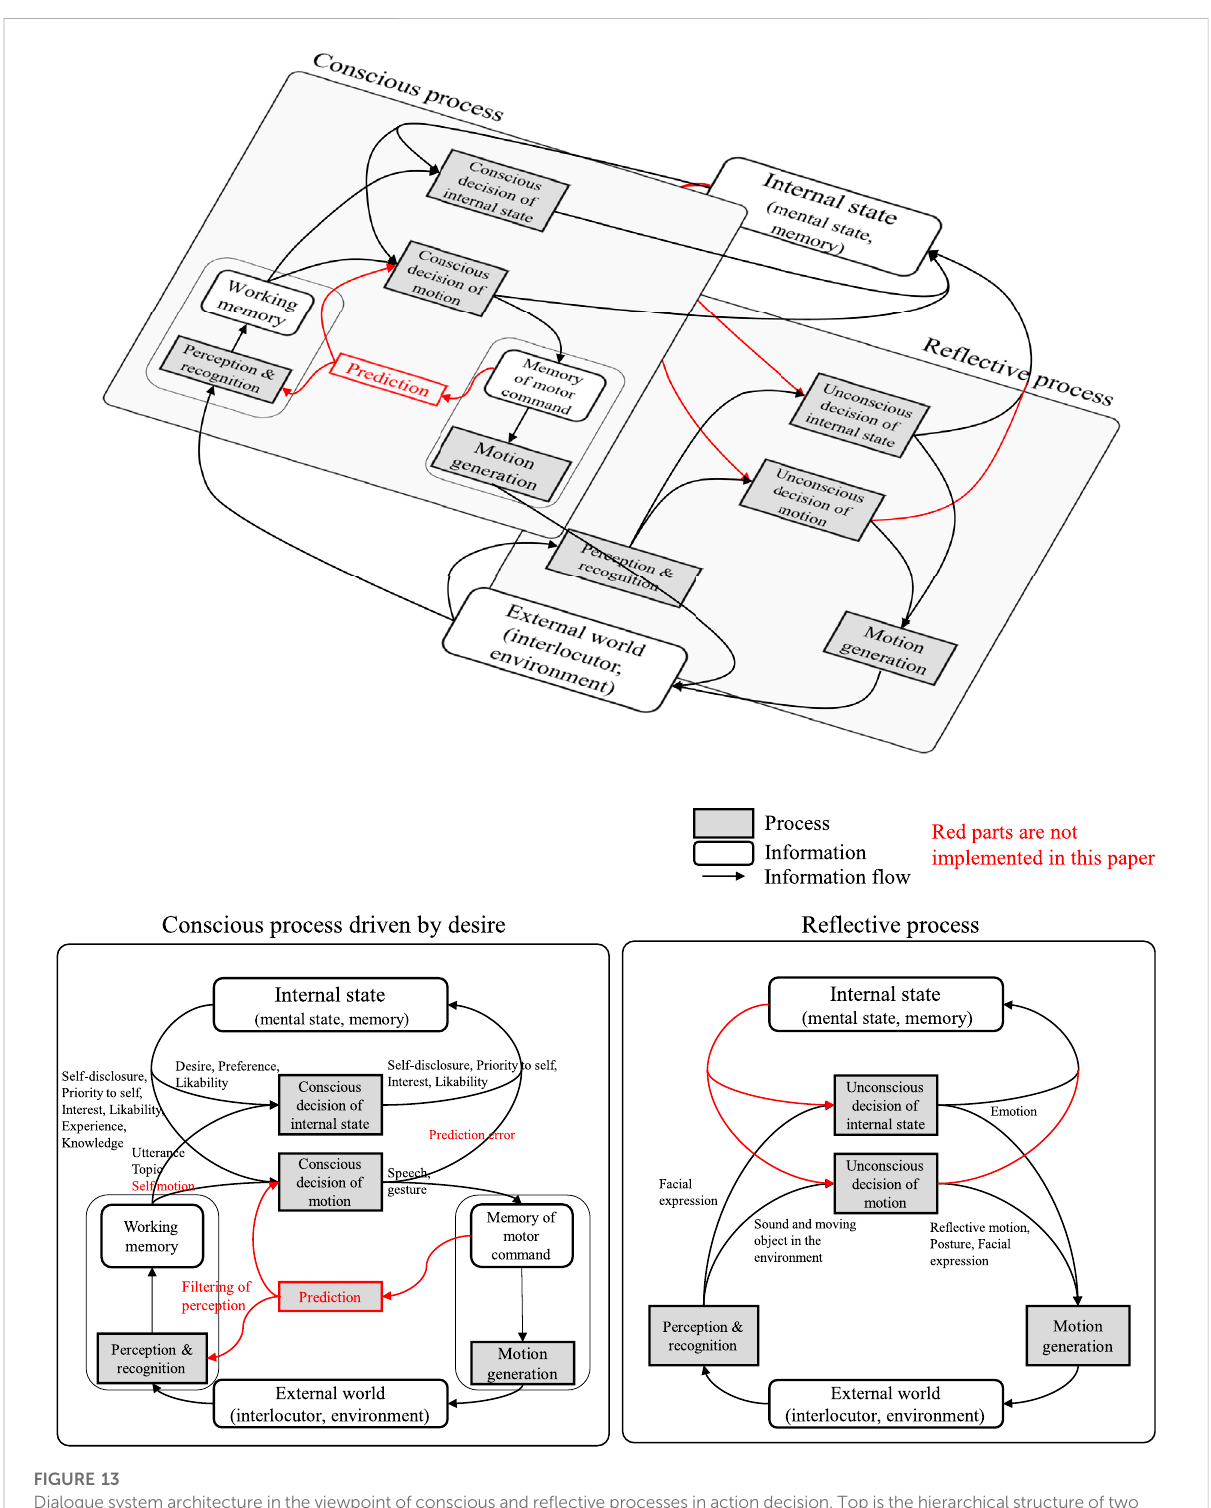
FIGURE 13 Dialogue system architecture in the viewpoint of conscious and re fl ective processes in action decision. Top is the hierarchical structure of two processes, and bottom is the detail of each process with the information fl